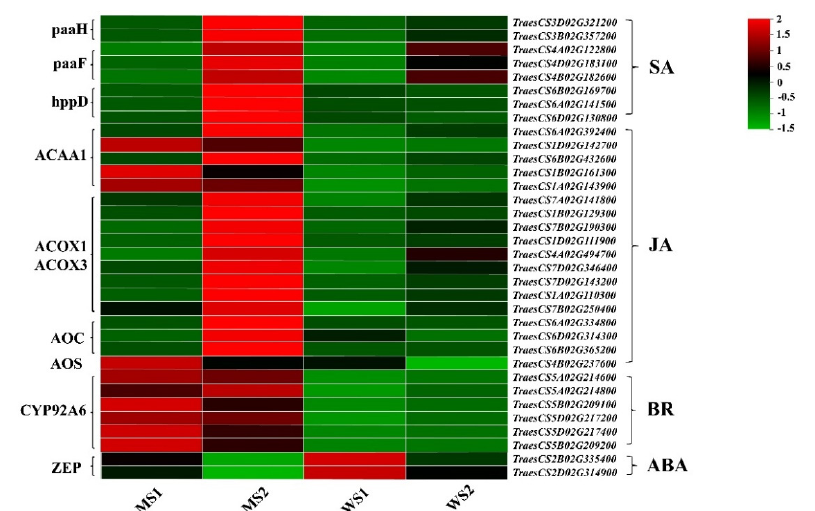
Figure 7. Expression profile clustering of genes involved in different hormone pathways. The expression ratio is standardized based on normalized transcripts per kilobase million (TPM) values, where each vertical column represents the mean of three samples (MS1, MS2, WS1 and WS2), and each horizontal row represents a sample single gene. 3.8. Differentially Expressed Genes Participating in Autophagy and Hydrolysis of Senescent